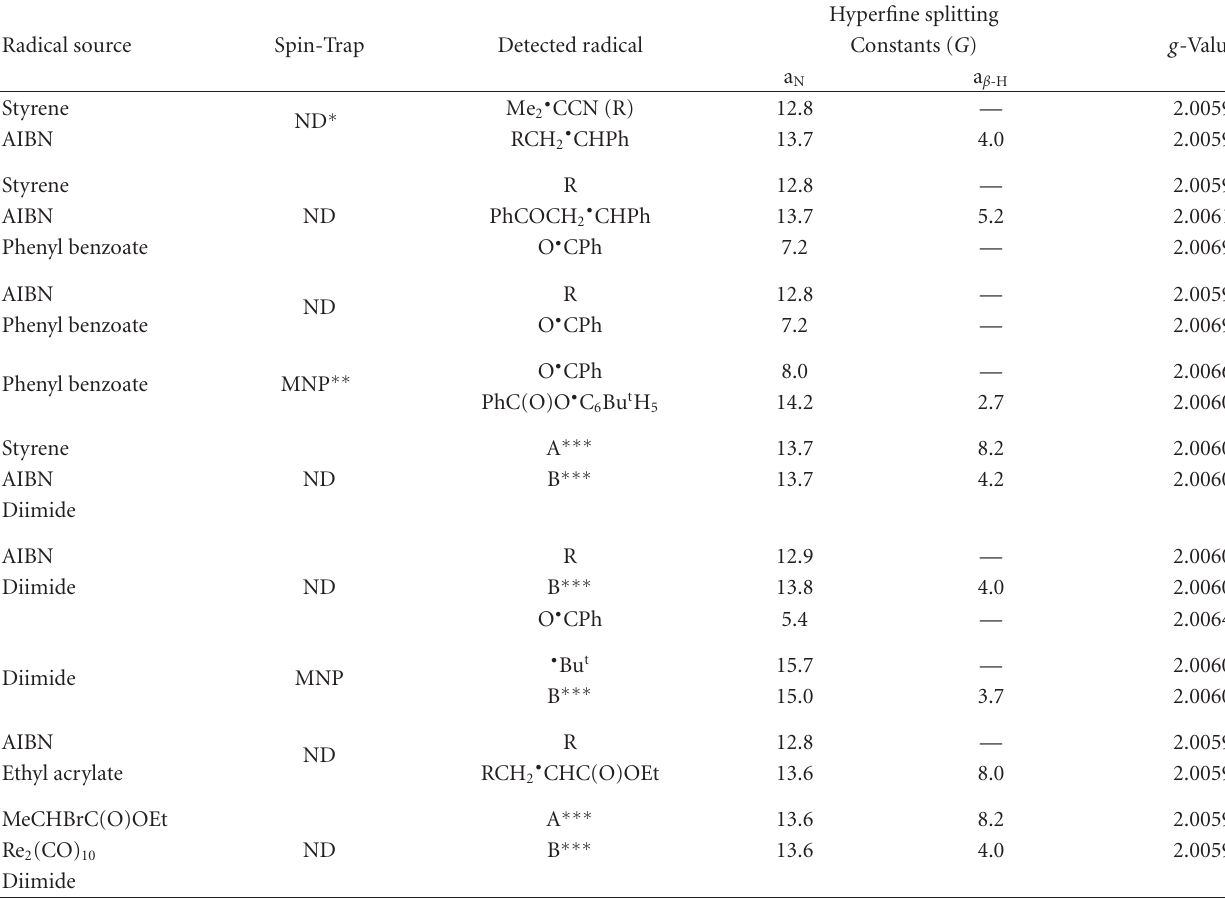
Table 3: ESR spectra data of nitroxyl radicals detected at irradiation of studied solutions. Solvent—CH 2 Cl 2 ; [Styrene] 0 , [Phenyl benzoate] 0